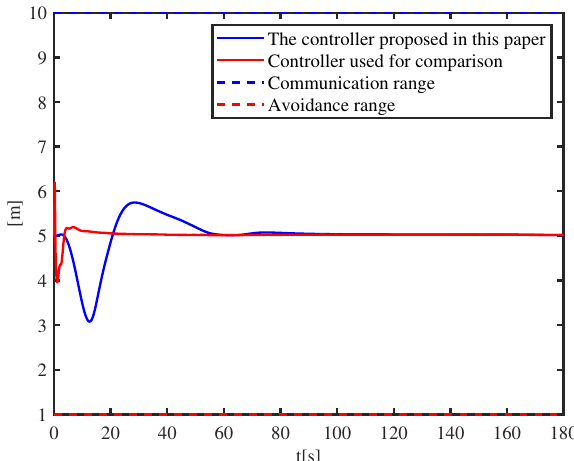
Figure 14. Relative distance under different controllers (the expected distance is 5 m, the minimum communication distance is 10 m and the maximum collision avoidance range is 1